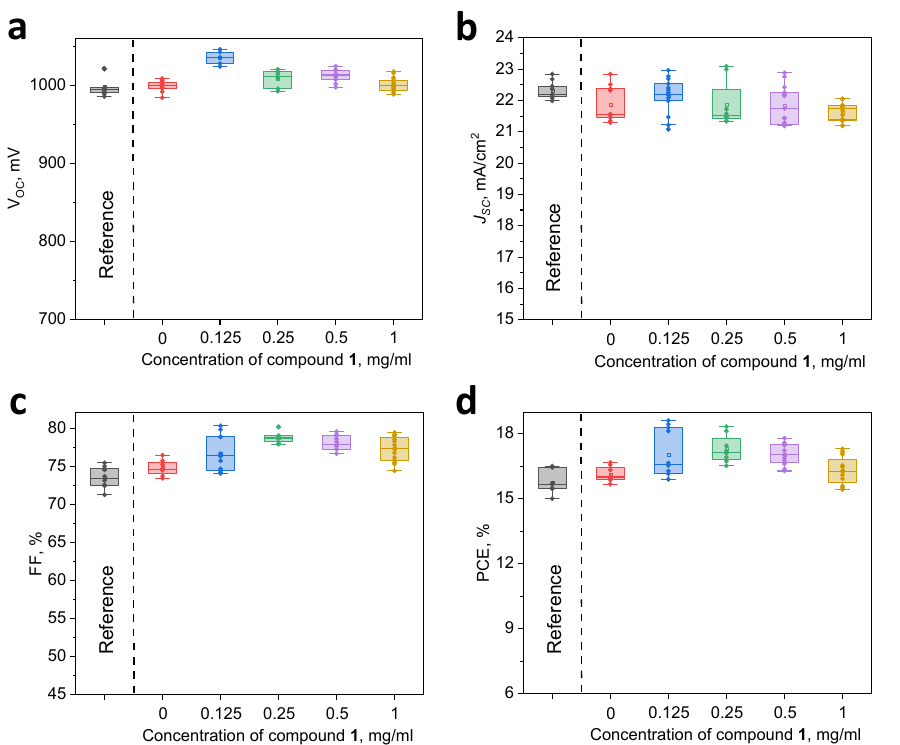
Figure 4. Open-circuit voltage, V OC ( a ); short-circuit current density, J SC ( b ); fill factor, FF ( c ); and power conversion efficiency, PCE ( d ), of perovskite solar cell as a function of the concentration of compound 1 in the solution used for films’ coating. Table 2. Characteristics of the solar cells, using derivatives 1 – 6 as interlayers (champion device characteristics are given in